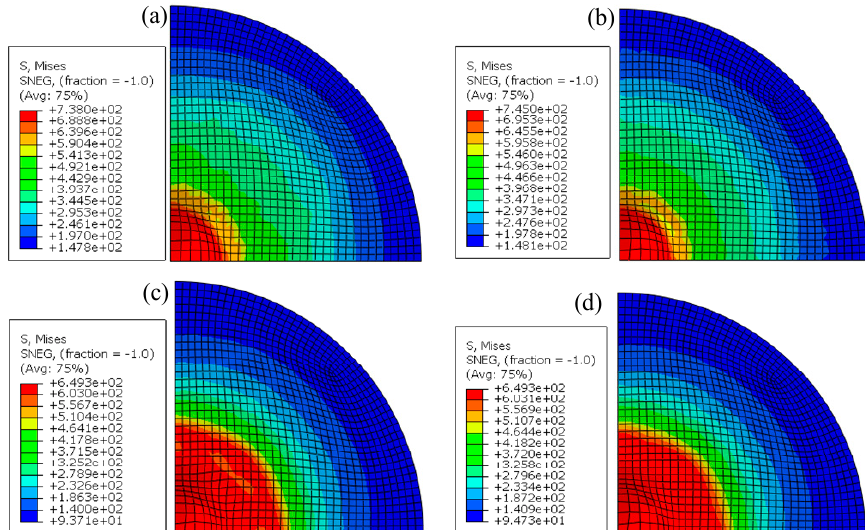
Figure 14. Numerical simulation results of the hemispherical part drawing under the blank holder force of 50kN and the punch stroke of 9.76 mm: ( a ) Single-layer model, ( b ) Substrate of the three- layers model (Binding), ( c ) Upper coating layer (Contact with the die) of the three-layers model (Binding), ( d ) Lower coating layer (Contact with the blank holder and punch) of the three-layers model (Binding).